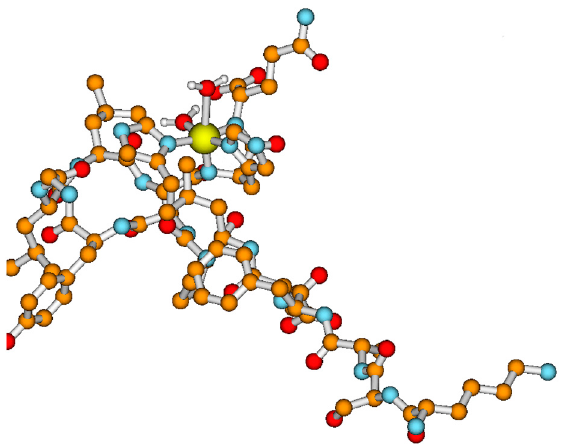
Figure 2. Lowest-energy conformer of CuL form of L1 (KSAFELPHYGLLAHQ) peptide obtained using theoretical calculations. All peptide hydrogen atoms are removed for the sake of clarity. Copper is shown in yellow, nitrogens in cyan, oxygens in red, carbon atoms in orange, and hydrogens in white.